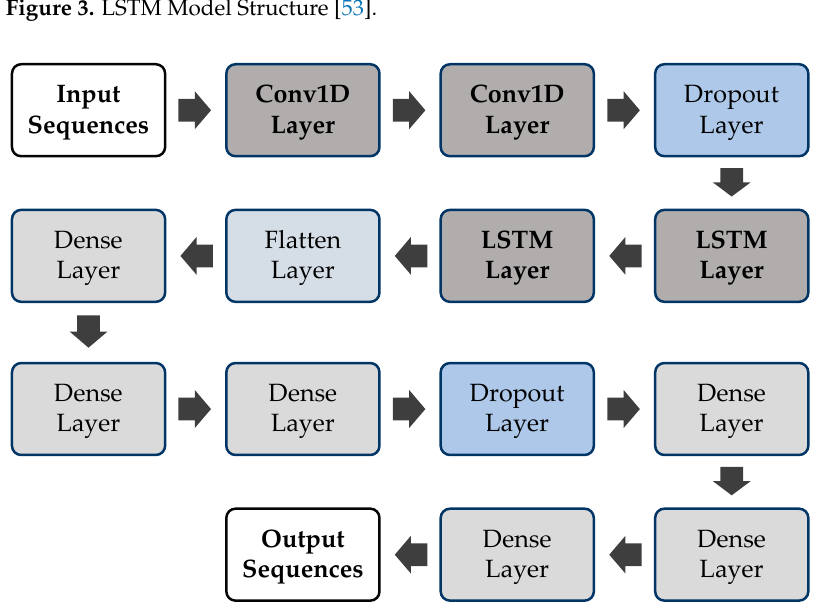
Figure 4. ConvLSTM Model Structure [53].